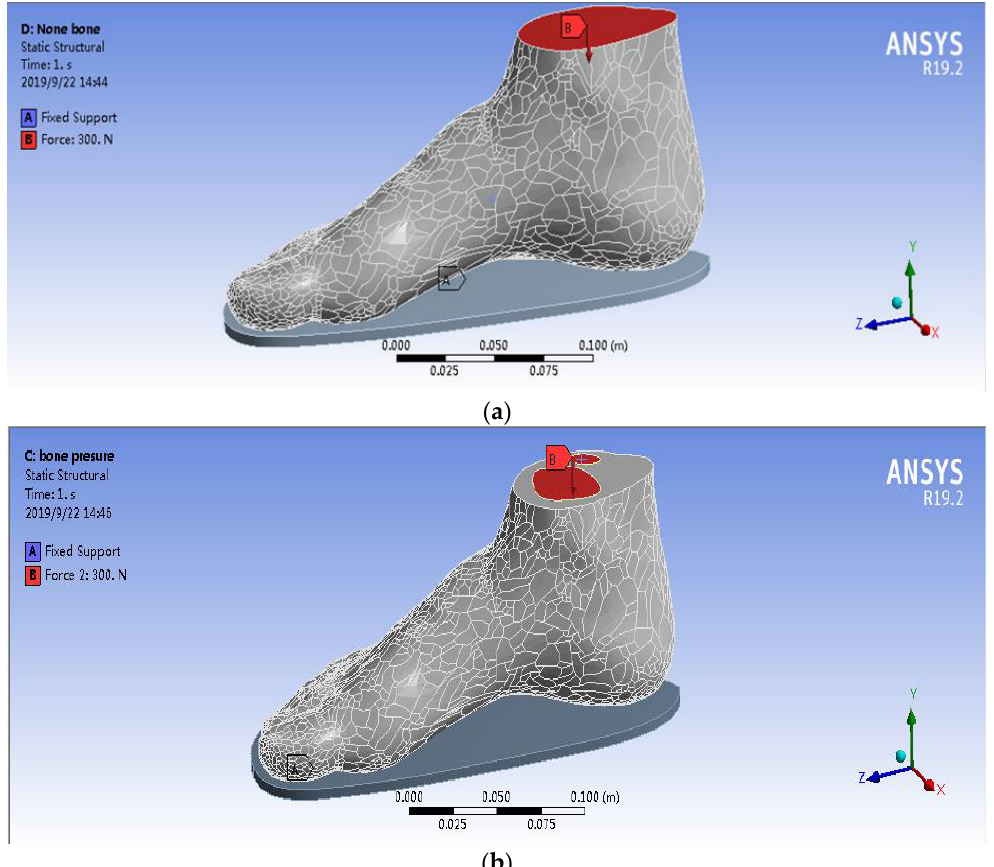
Figure 5. Loading definition of the FEA model. ( a ) WM and ( b ) SSM.